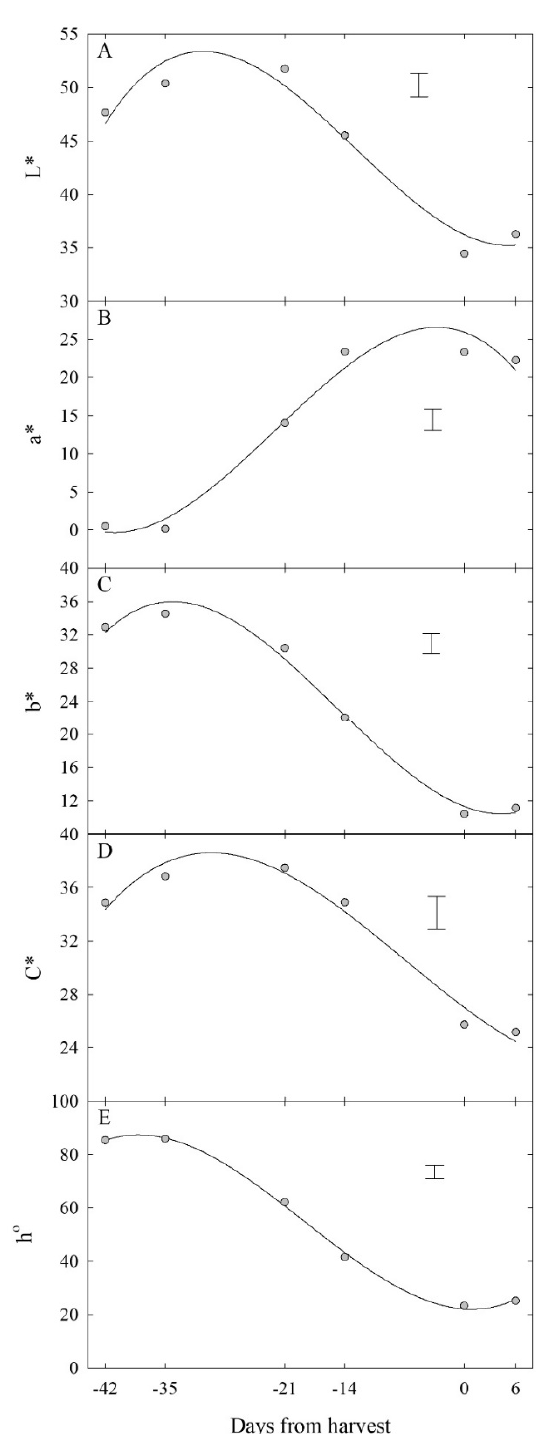
Figure 5. Cubic regression fits of skin L* ( A ), a* ( B ), b* ( C ), C* ( D ) and h° ( E ) against time ( n days from harvest) in ‘Majestic Pearl’ nectarine fruit. Significant differences are shown with Fisher’s Least Significant Difference (LSD, 5%)